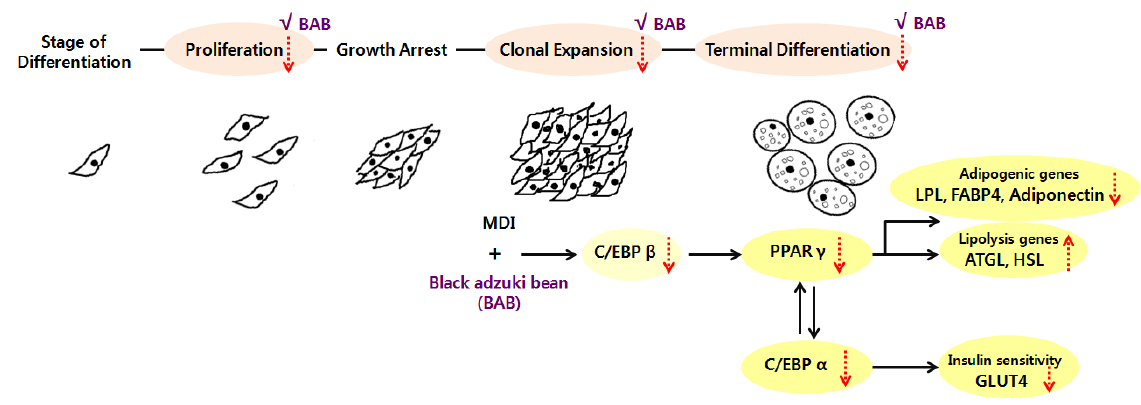
Figure 7. The possible mechanism of black adzuki bean-mediated inhibition of adipocyte